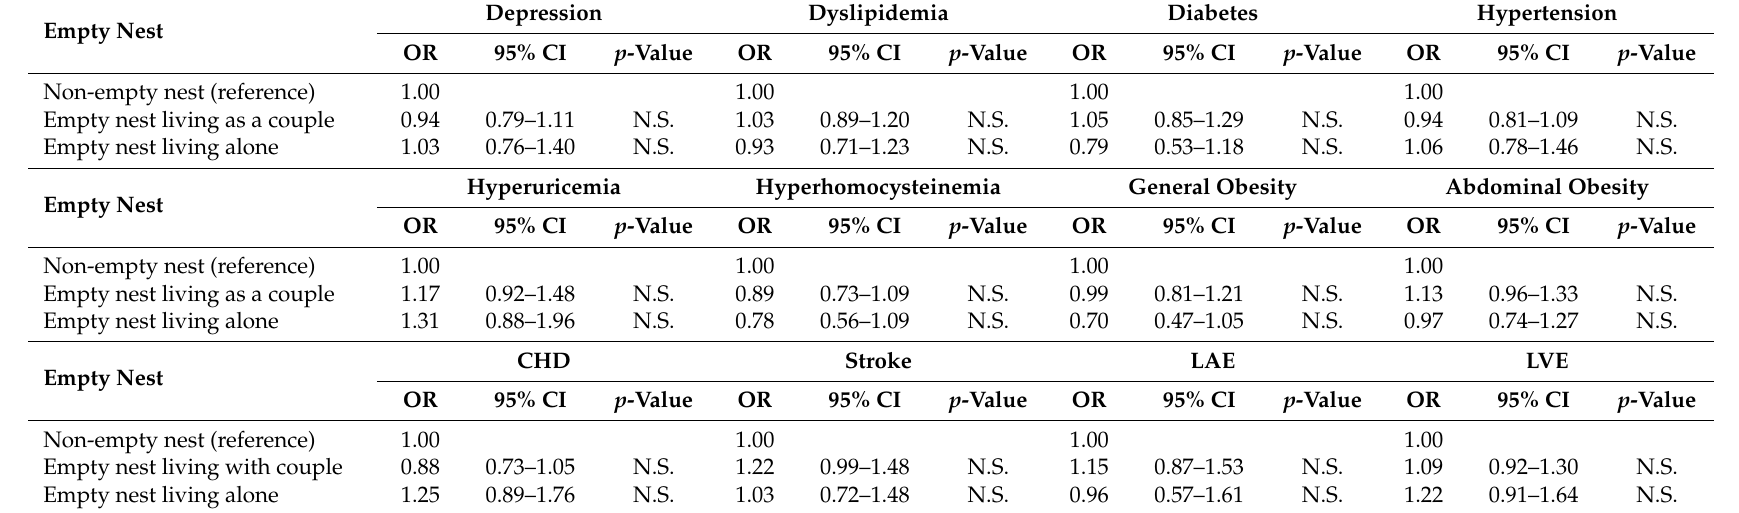
Table 4. Multivariable logistic regression analyses on the association between the three groups of living arrangement and comorbidities a .